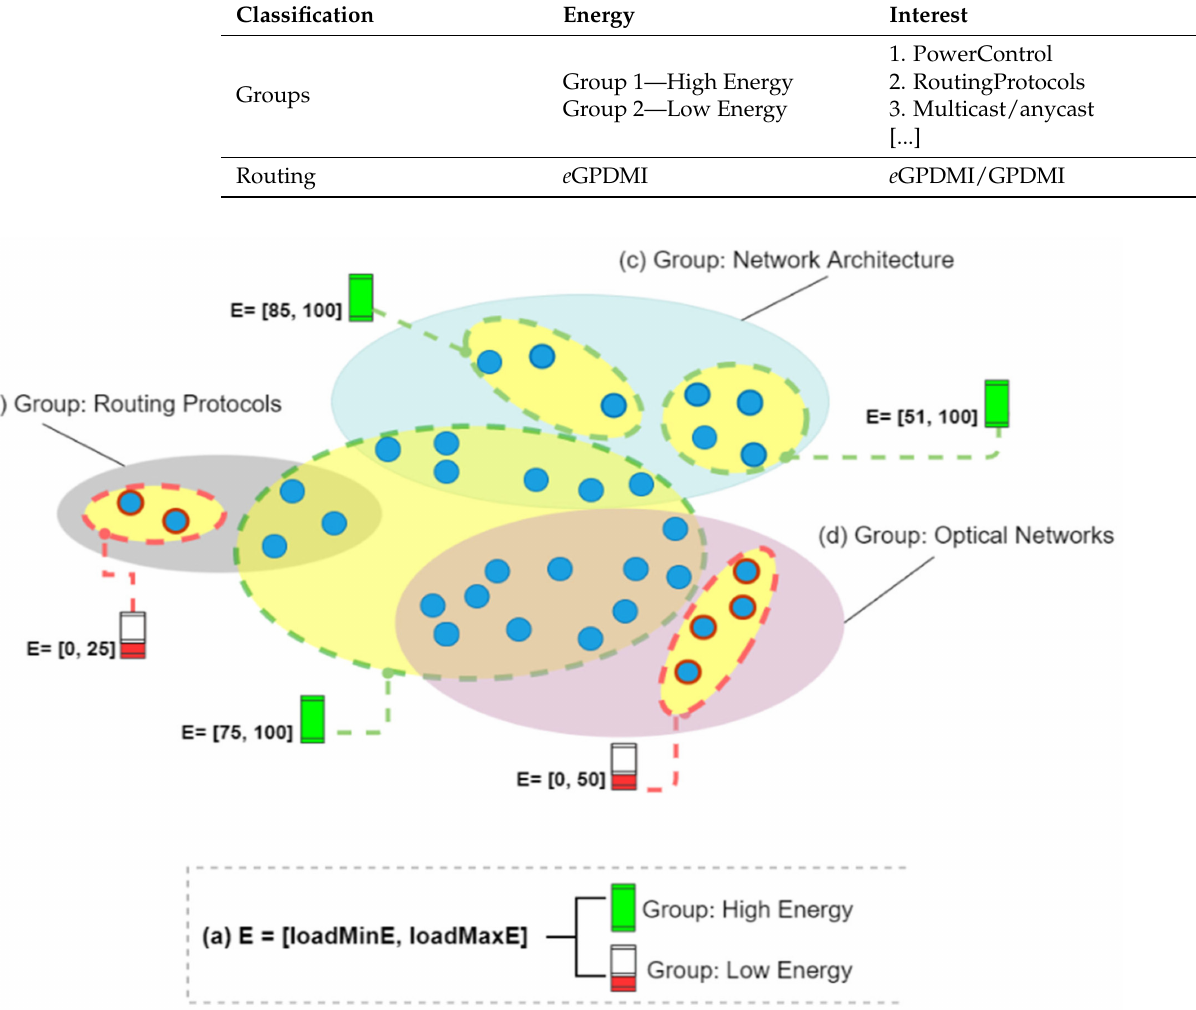
Figure 2. Formation of groups by energy levels and common